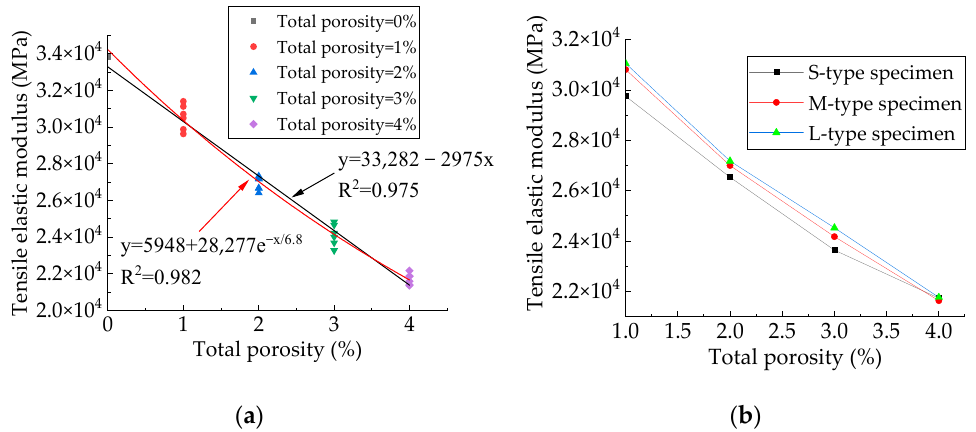
Figure 16. Relationship between total porosity and elastic modulus. ( a ) Tensile elastic modulus of all specimens; ( b ) Tensile elastic modulus of three types of specimens.